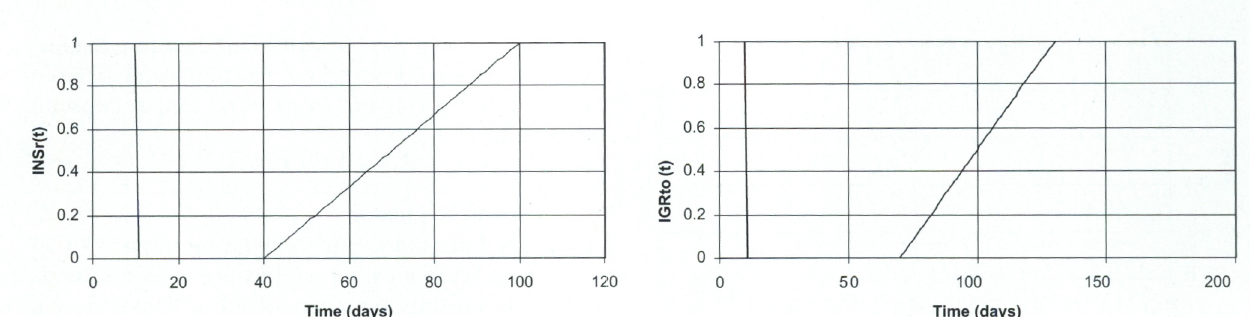
Fig. 4. - IGRto(t) as a function of time for treatment carried out at t = 10 days. The figure 0 corresponds to 100 % mortality, and 1 to the maximum number of adult fleas (100 % viable).